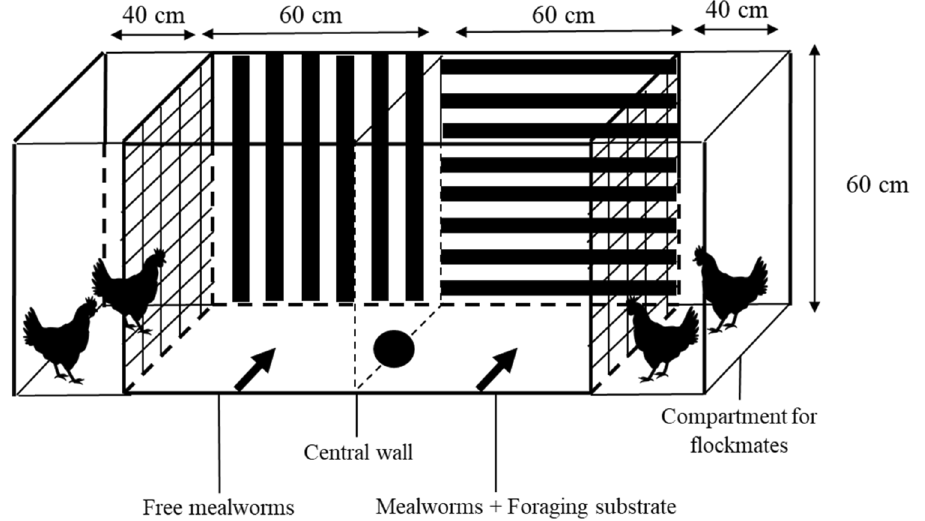
Figure 2. Side view of the arena (compartments and dimensions) used during the contrafreeloading conditioned place preference task (CPP). All over the task, and for all periods of testing, the extremes of each chamber were fenced to house two flockmate chickens (not tested). Chickens were always placed in the center of each chamber (conditioning, dark arrows) or the center of the apparatus when the wall was not present (test, dark